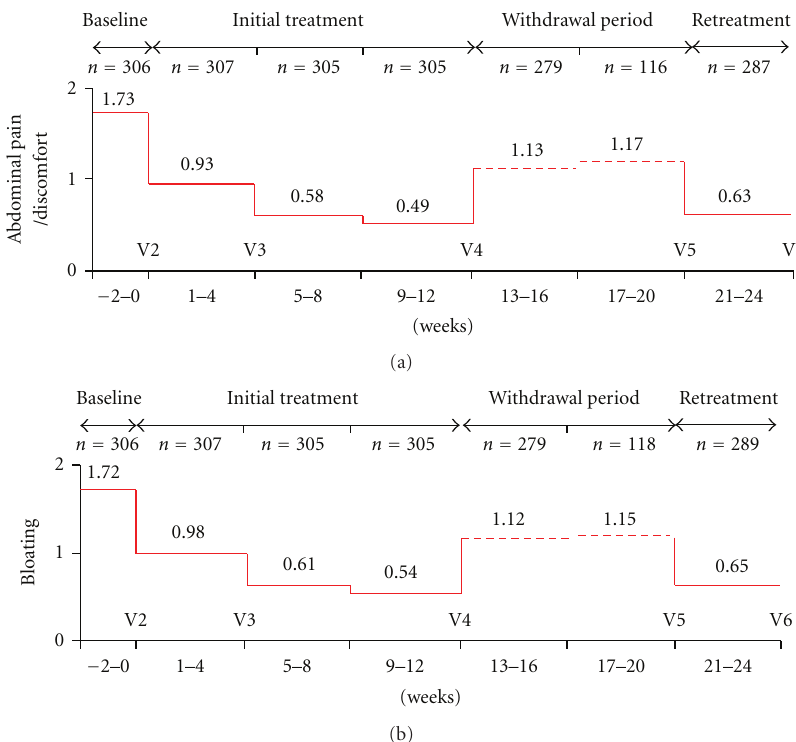
Figure 3: Mean abdominal pain/discomfort score (a) and bloating score (b) in patients cohort enrolled in retreatment phase with tegaserod. Modified from [8].